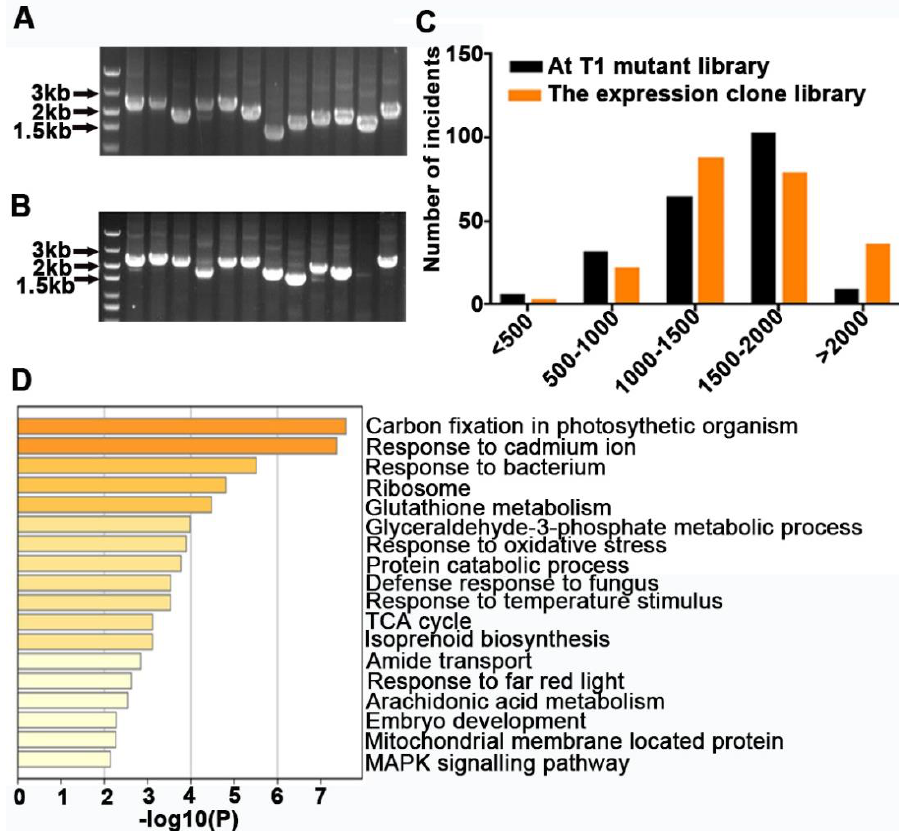
Figure 1. Construction of a genome-wide Populus -Full-length cDNA Over-eXpressing (FOX)- Arabidopsis library. ( A ) Size distribution of full-length cDNA transgenes in entry vector. ( B ) Size distribution of full-length cDNA transgenes in expression vector. ( C ) Sequence lengths of 200 randomly selected clones from the expression clone library and 200 cDNAs from T1 transgenic plants. ( D ) Functional annotation and classification according to Kyoto Encyclopedia of Genes and Genomes (KEGG) pathway assignments of full-length cDNA transgenes in Arabidopsis thaliana .